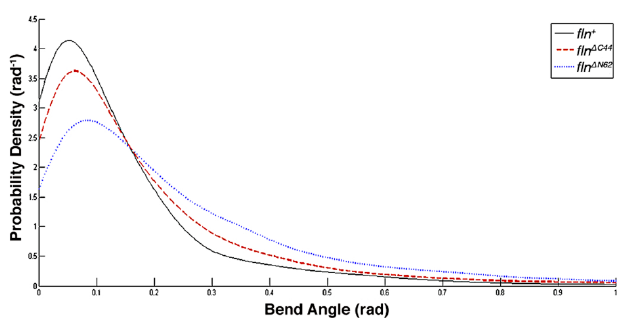
Figure 5. The von Misses distribution fit to the frequency of bend angles found in thick filaments from each transgenic line. Note that larger bend angles (>0.16 rad) are more frequently found in filaments lacking the amino terminal domain (blue dotted line) than in control (solid black line) and filaments lacking the carboxy terminal domain (red broken line). Similarly, smaller bend angles (<0.16 rad) are more frequently found in thick filaments from control flies and from flies expressing lacking the carboxy terminal domain.